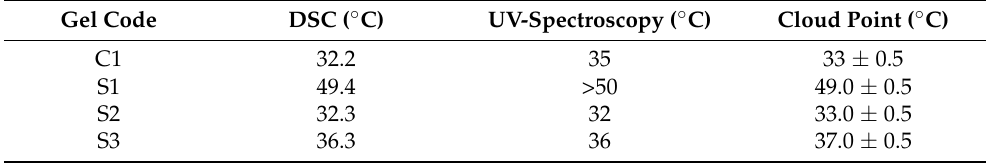
Table 4. LCST of NVCL-based samples established using DSC, UV-spectroscopy, and cloud point.